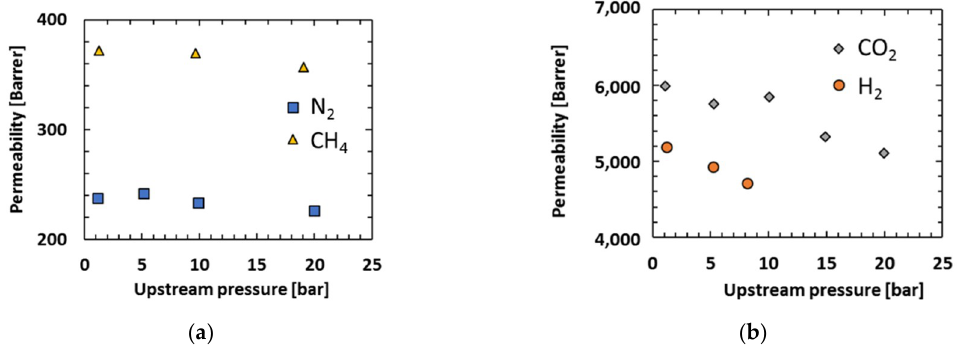
Figure 6. Permeability coefficients of PIM-EA(H 2 )-TB for CH 4 , N 2 ( a ) and H 2 , CO 2 ( b ) at 30 °C.